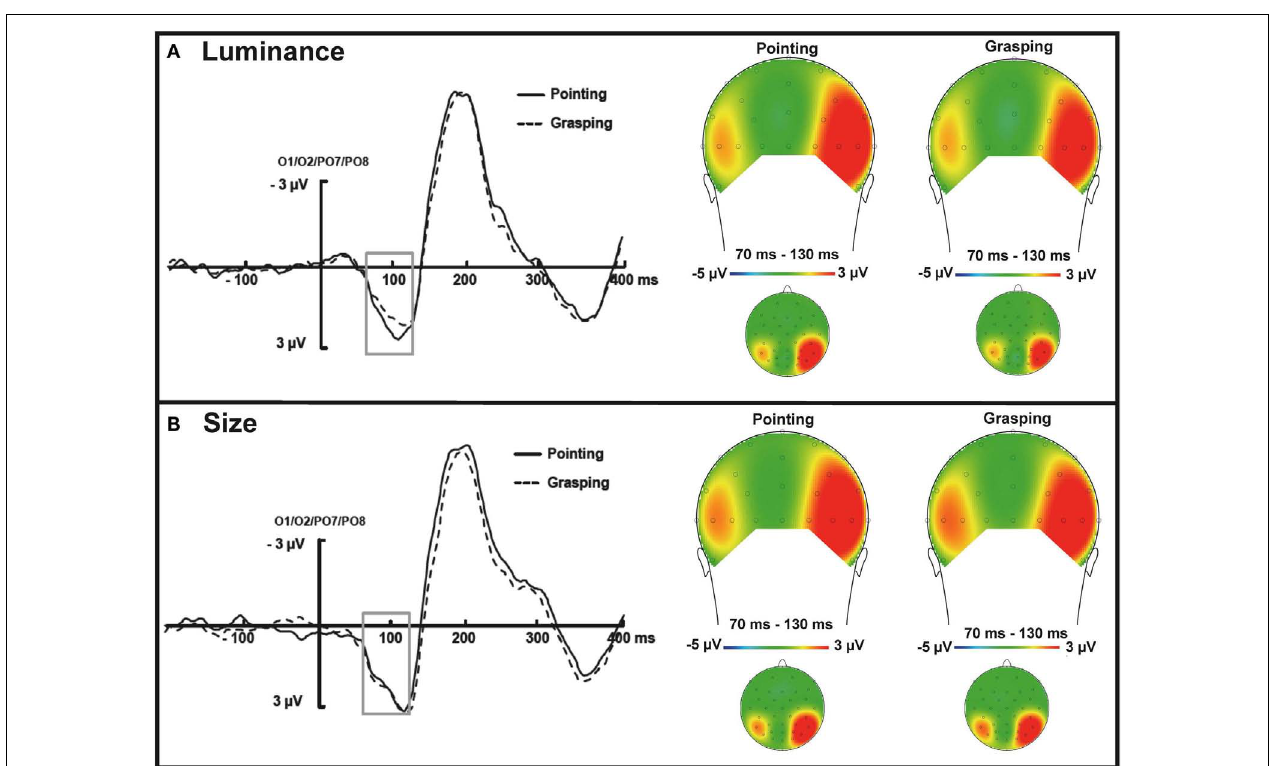
presented from posterior view (larger images) and top view, all channels (smaller images, front plotted upwards). Note that the scalp distribution of the mean amplitude within the P1 component time window indicates a larger positivity on the right electrode sites, independent of condition.This might be related to the fact that attentional networks are located mostly in the right cerebral hemisphere (e.g., Heilman andVan Den Abell, 1980; Mesulam, 1981; Sperry, 1974;Thiebaut et al., 2011), and is in line with previous findings on attentional orienting that showed validity effects in a cueing paradigm also predominantly on right lateral electrodes (e.g., Mangun and Hillyard,